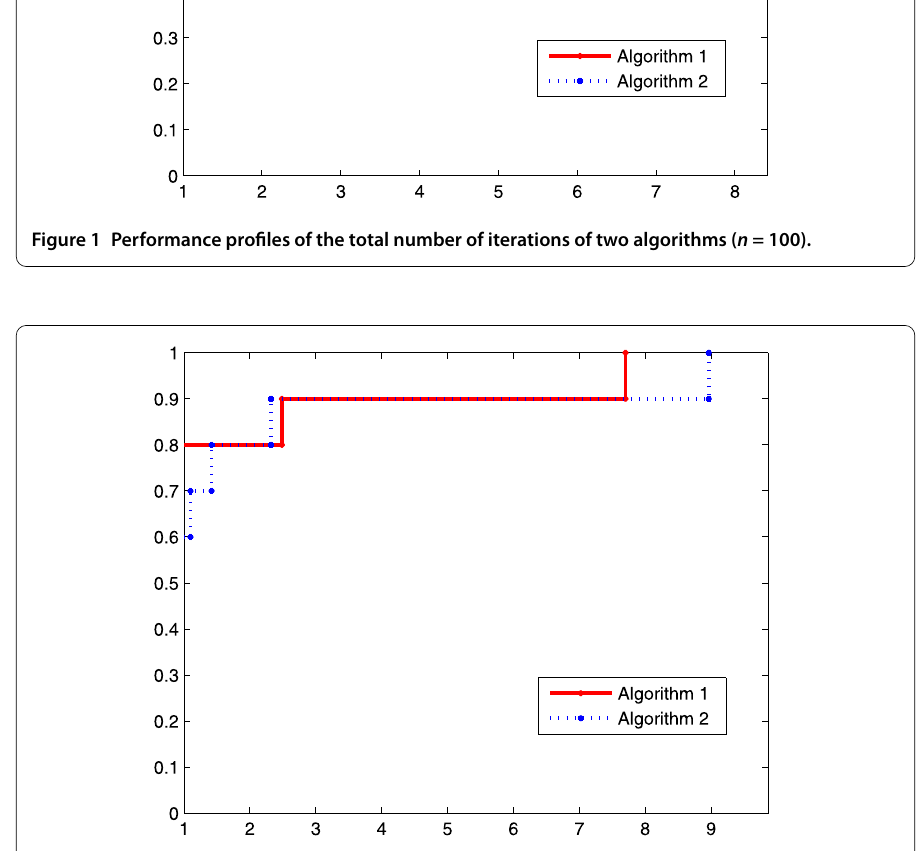
Figure 2 Performance profiles of the total number of iterations of two algorithms ( n = 1,000).